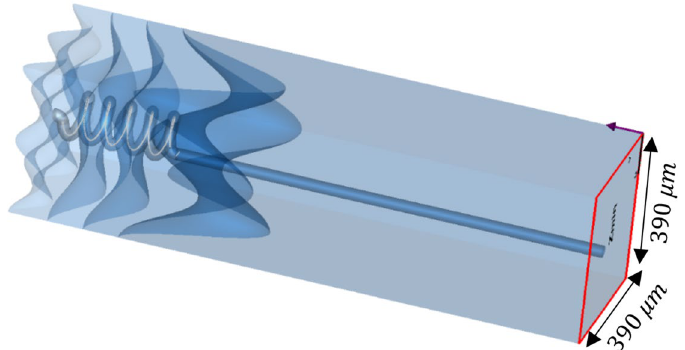
Figure 6. Electromagnetic excitation signal applied to the Z min port, using 18 modes of Floquet. This figure was generated using CST STUDIO SUITE v2021 30 , https:// www. 3ds. com/ produ cts- servi ces/ simul ia/ produ cts/ cst- studio- suite/.